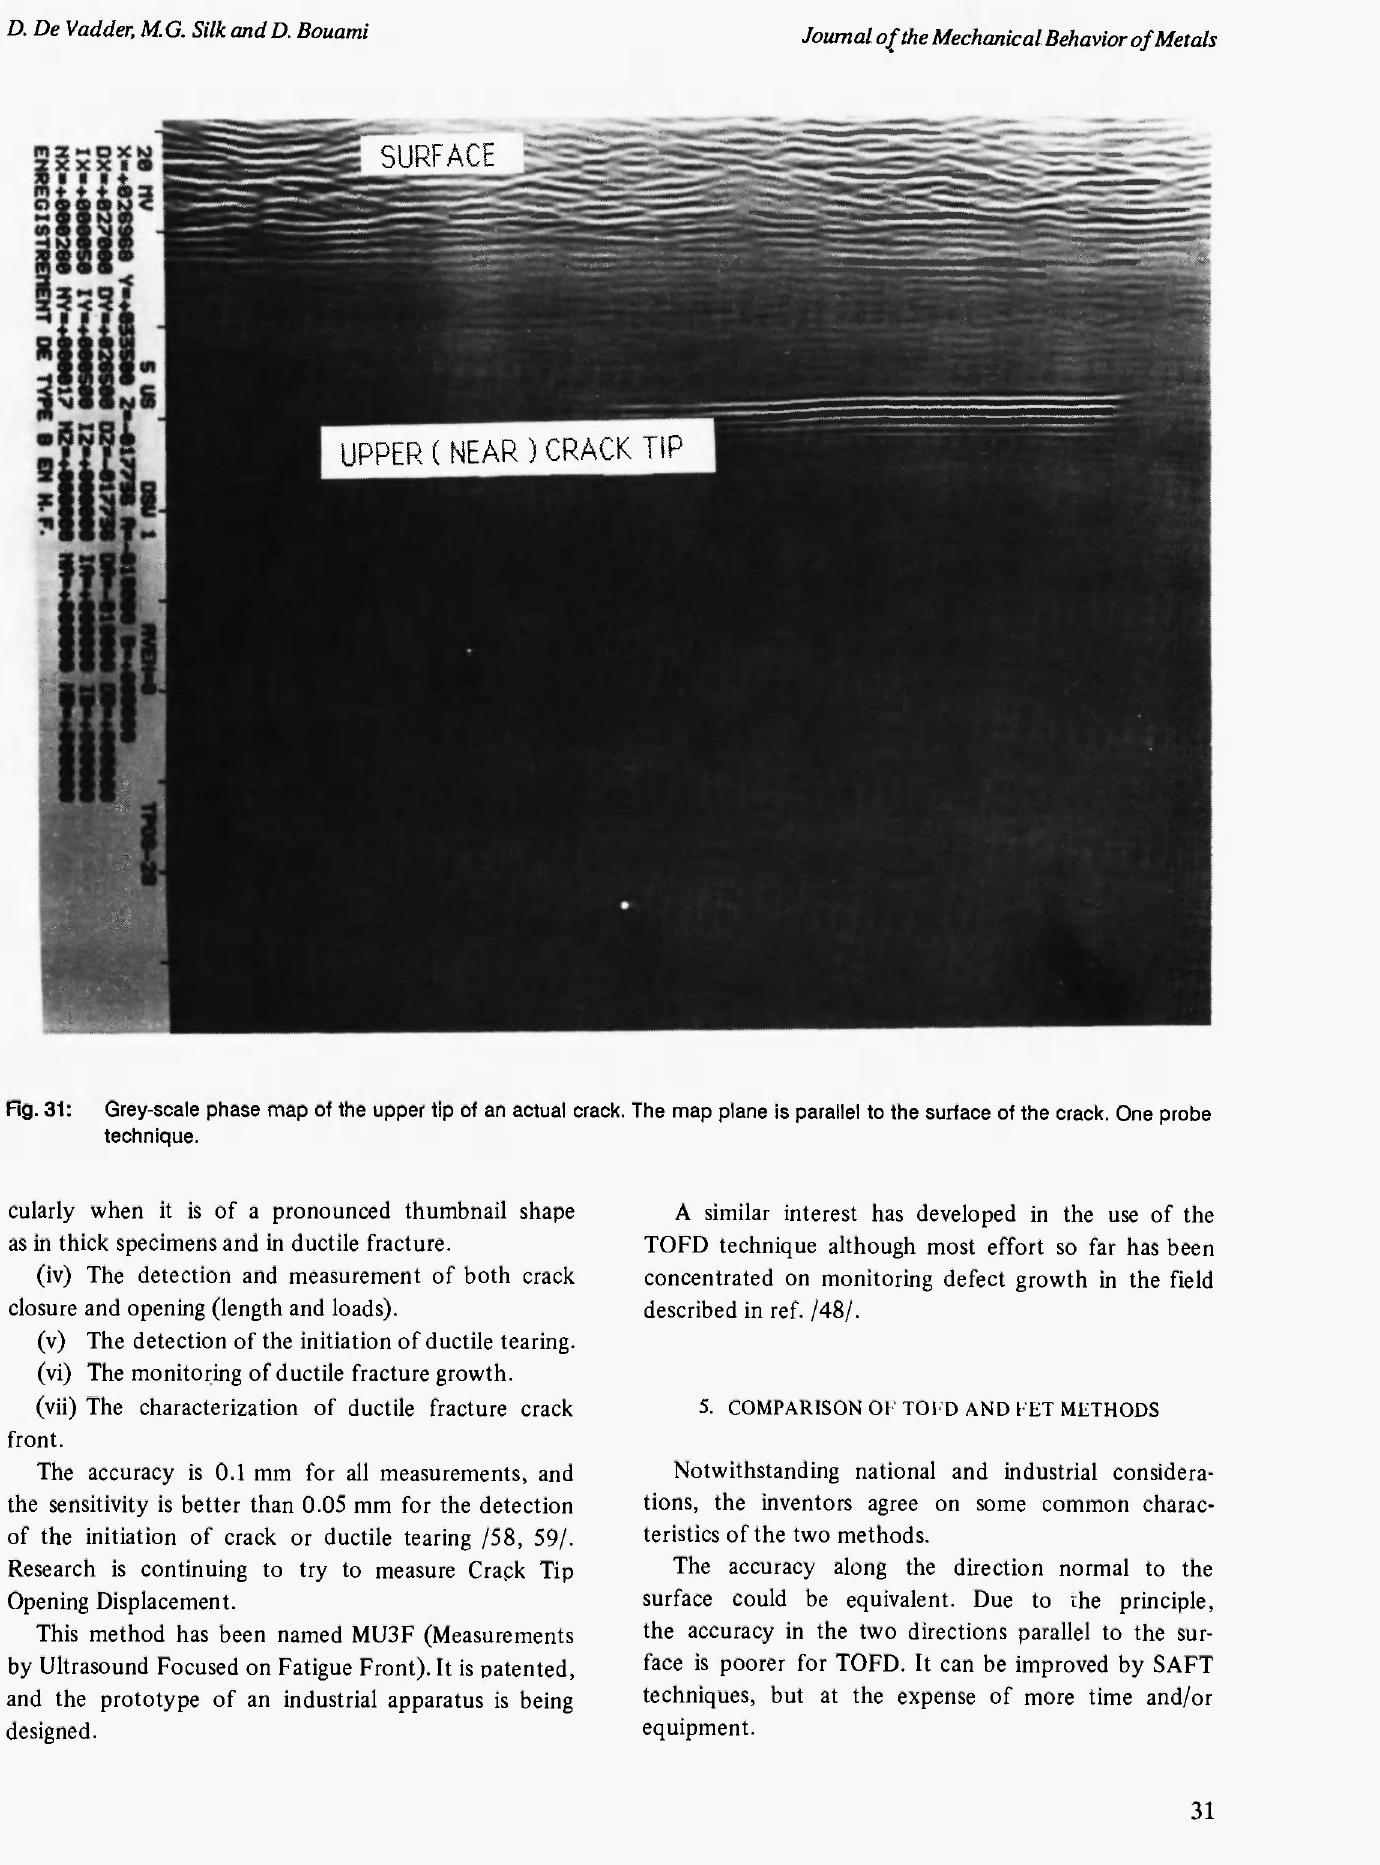
Fig. 31: Grey-scale phase map of the upper tip of an actual crack. The map plane is parallel to the surface of the crack. One probe technique.